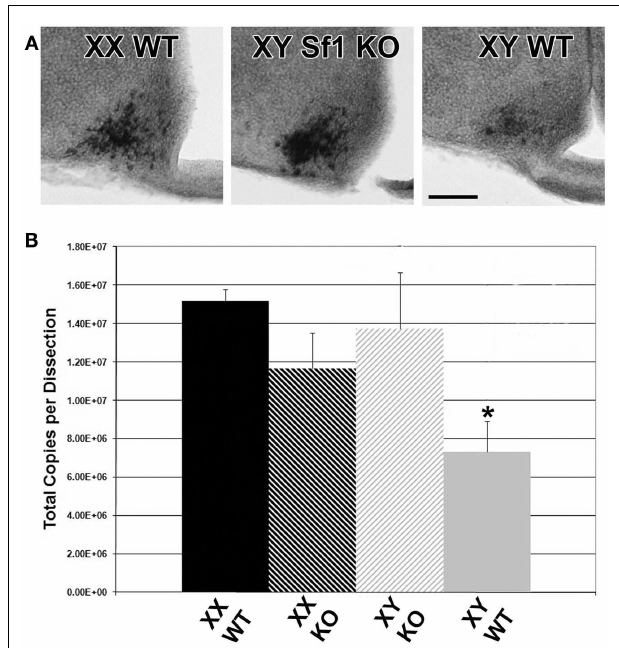
FIGURE 7 | Pre-natal Kiss1 expression is gonad dependent . Digital images of coronal sections in (A) show that E17 Sf1 KO XY resembleWT XX more thanWT XY mice by qualitative inspection of ISH reaction product. QPCR quantification of Kiss1 (B) reveals a significant effect of sex by genotype withWT males expressing less Kiss1 than KO males or females of either genotype ( n = 3 per group; mean ± SEM. After a significant interaction between sex and genotype, * p < 0.05 indicates a specific of XY KO to XXWT. 3V, third ventricle; ME, median eminence. Scale bar = 100 µ